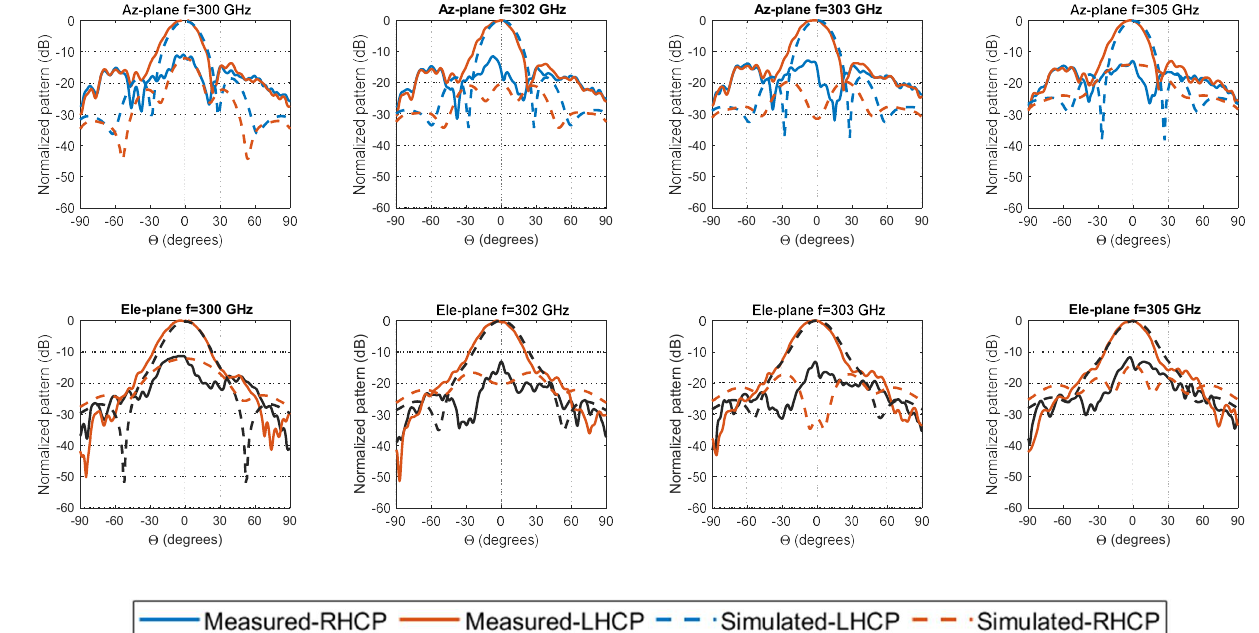
Figure 8. Measured (solid lines) and simulated (dashed lines) radiation pattern of the CP-FPC antenna at 300, 302, 303, and 305 GHz for azimuth (Az.), and elevation (Ele.)-plane cuts.